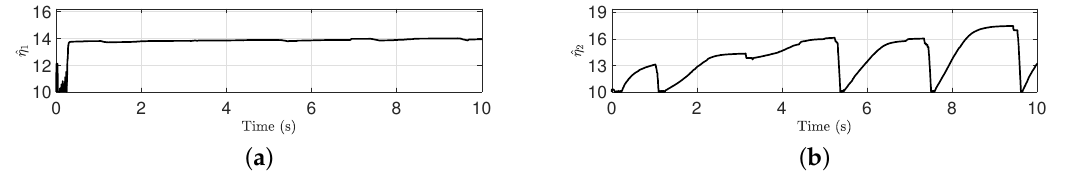
Figure 4. Update parameters generated by the proposed SS-ASMC approach: ( a ) Joint 1 ( × 10 2 ). ( b ) Joint 2 ( × 10 2 ).